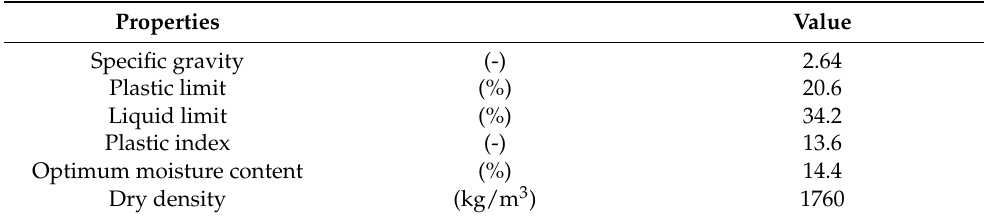
Table 1. Physical properties of the loess in the present